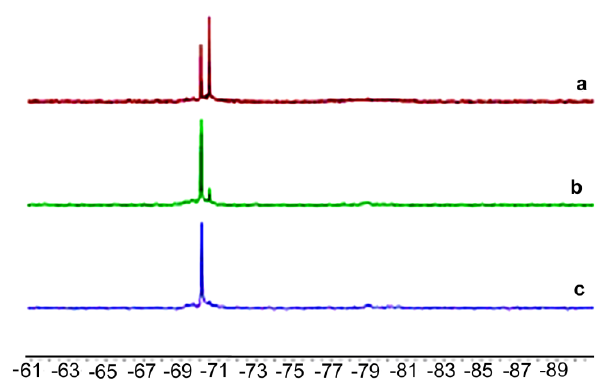
Figure 3. 29 Si NMR spectra of m -tolylcyclosiloxanes obtained from the reactions of 1 conducted at C HCl = 0.054 mol L −1 for 48 h ( a ), 120 h ( b ), and 475 h ( c ).